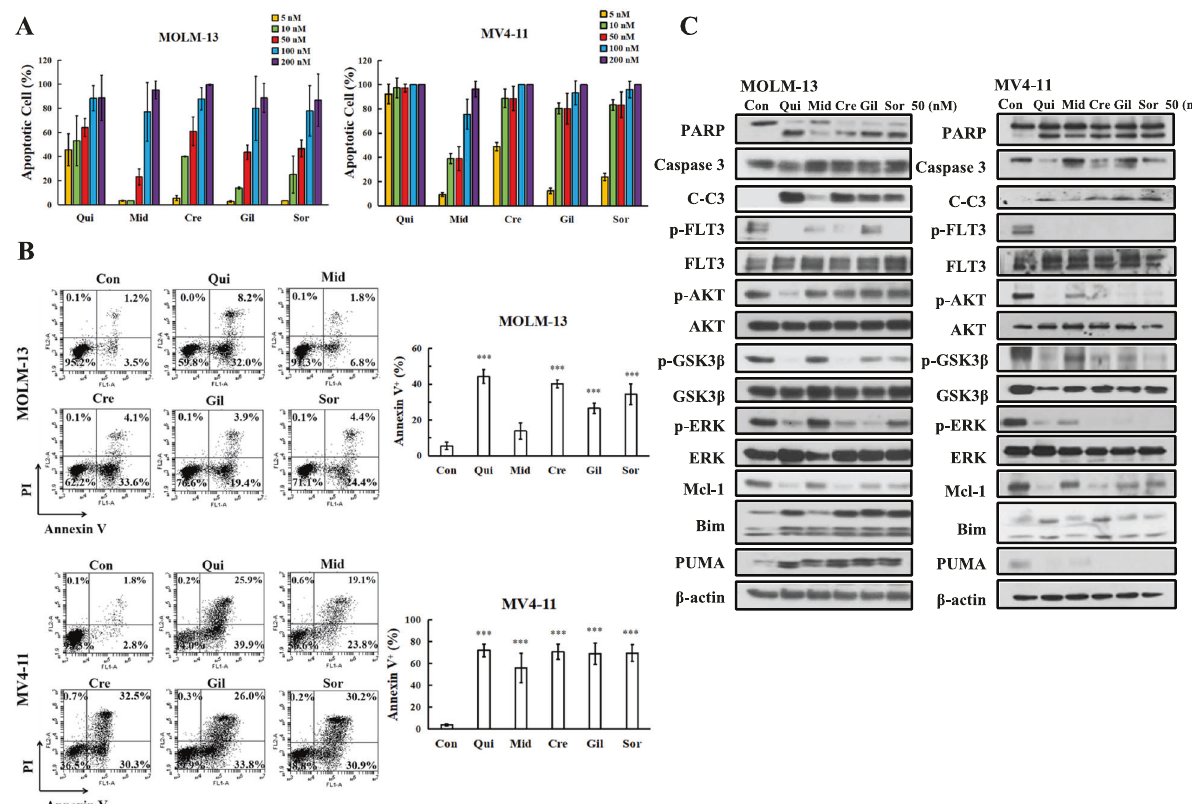
Fig. 1 FLT3-ITD inhibitors induce apoptosis with reduced levels of Mcl-1 and p-GSK3 β . A Apoptosis detected by AO-EB staining. B Apoptosis detected by Annexin V/PI staining. C Protein levels measured by Western blot analysis. MOLM-13 and MV4-11 cells were treated with each inhibitor at the indicated concentrations for 24 h. Column fi gures show the mean plus SD of three independent experiments. *** P < 0.001 compared with the control